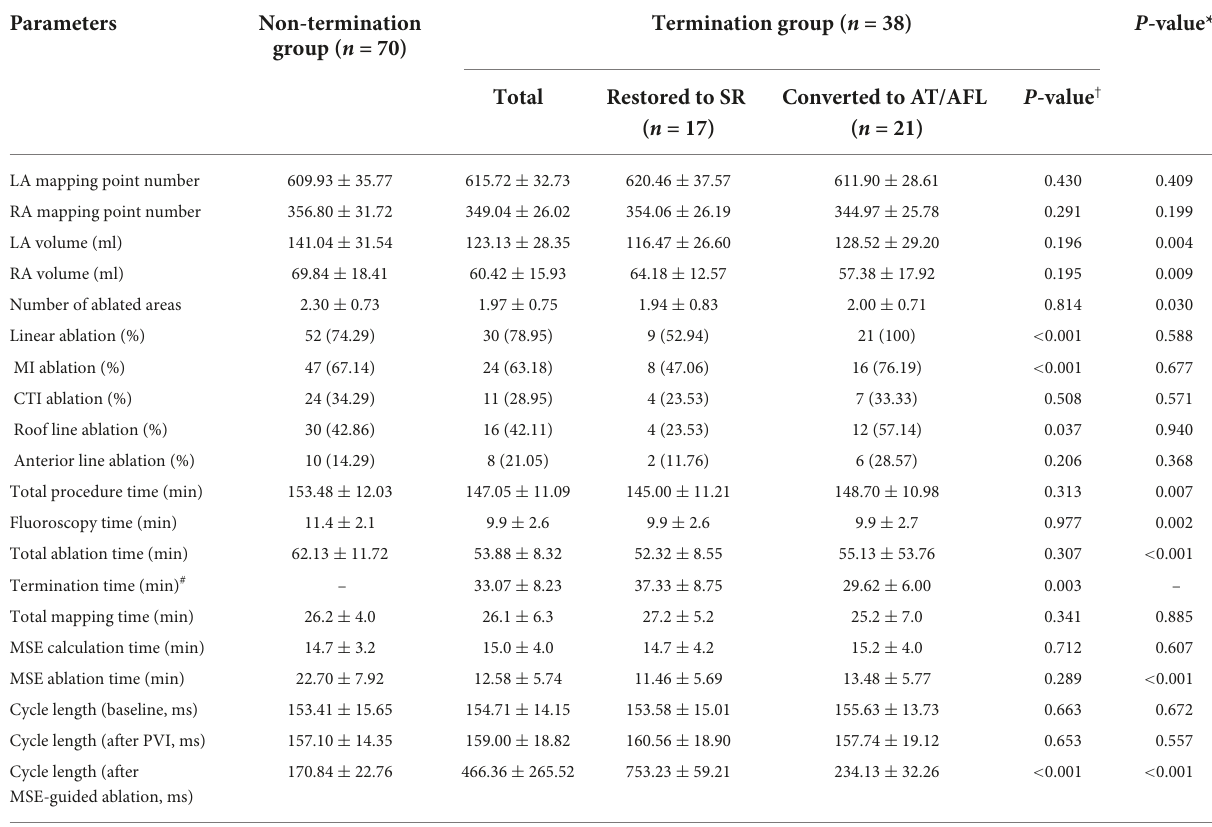
TABLE 2 Acute procedure outcome and intraprocedural parameters of